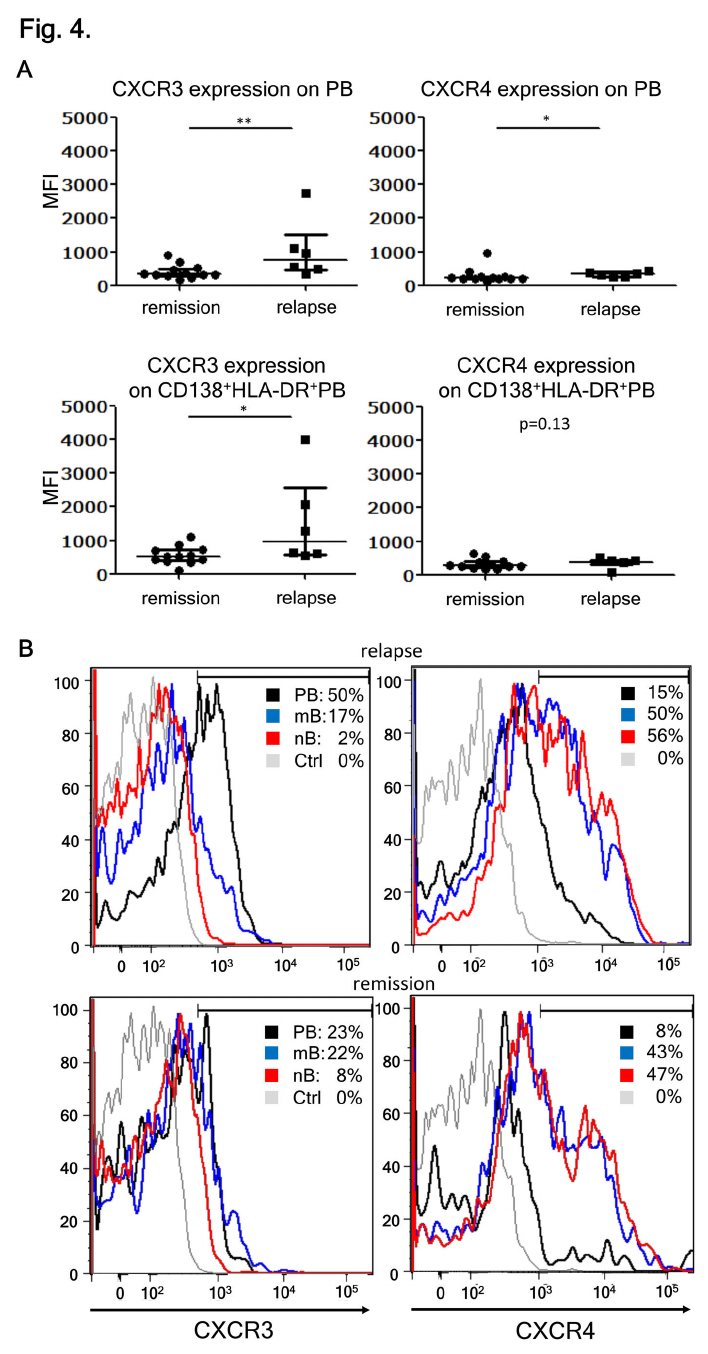
Figure 4. CXCR3 expression on plasmablasts (PBs) correlates with the disease state. (A) CXCR3 and CXCR4 on PB in neuromyelitis optica (NMO) relapse and remission. Here, we compared the mean fluorescence intensity (MFI) of CXCR3 and CXCR4 expression in the peripheral blood PBs during remission and relapse of NMO. MFI of CXCR3 and CXCR4 expressions on CD138 + HLA-DR + PBs were also analyzed [**p < 0.01 and *p < 0.05 by Mann–Whitney test; each error bar represents the median ± interquartile range (IQR]]. (B) B-cell subpopulations derived from peripheral blood mononuclear cells (PBMC) during disease relapse and remission were analyzed by flow cytometry to investigate the expression of CXCR3 and CXCR4. The values represent the percentages of CXCR3 + or CXCR4 + cells within each B-cell subpopulation. Unstained control of PBMC is indicated by Ctrl. Representative data of at least five patients in each disease state are shown. doi: 10.1371/journal.pone.0083036.g004 PLOS ONE |